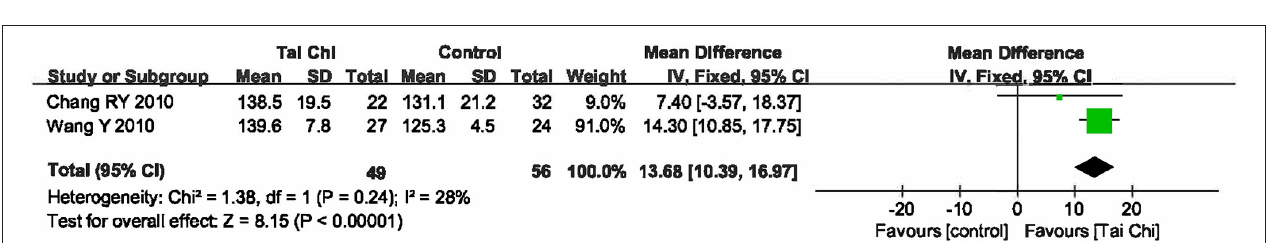
FIGURE 4 | Forest plot of the comparison between Tai Chi and positive control for the outcome HR peak.